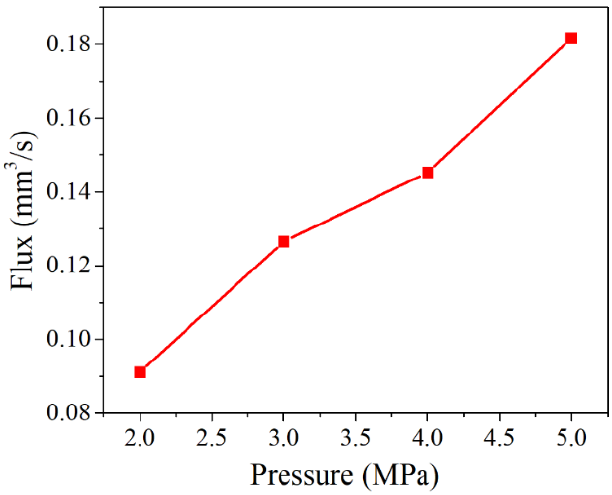
Figure 11. The relationship between the internal pressure of medium and leakage rate.